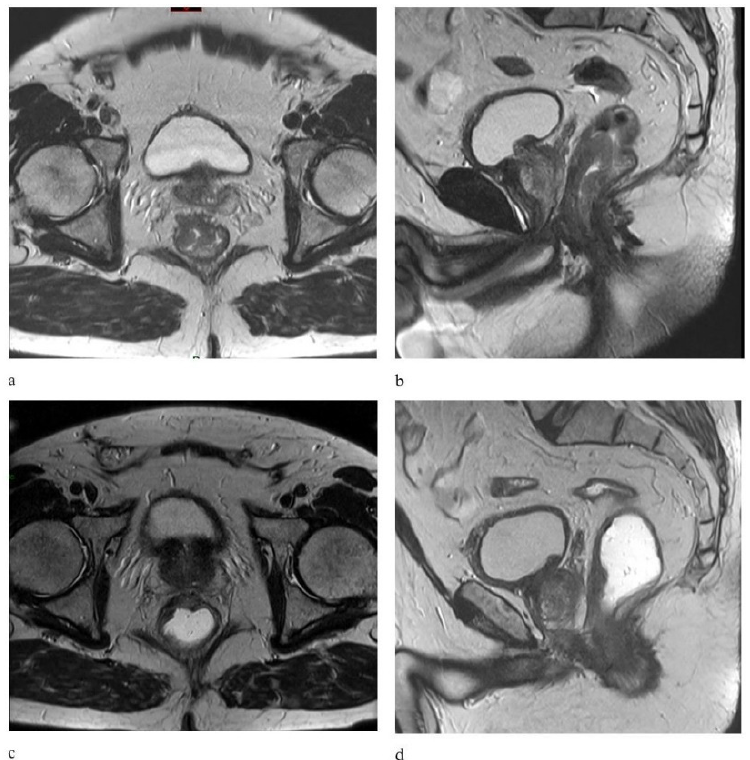
Figure 2. Axial and sagittal T2-weighted MR images show a distal rectal tumor with mesorectal fascia (MRF) infiltration in a patient with a clinical staged T3-N1 tumor before ( a , b ) and after chemoradiotherapy ( c , d ) showing a locally advanced rectal cancer with a good response to neoadjuvant chemoradiotherapy. MR, magnetic resonance.